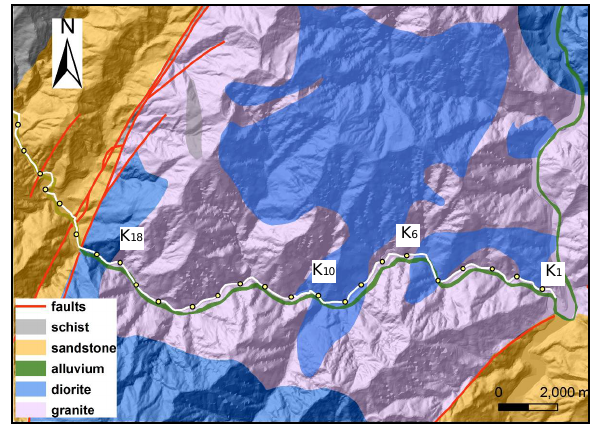
Fig. 6. Photo of a loose deposit that buried a part of PR303.